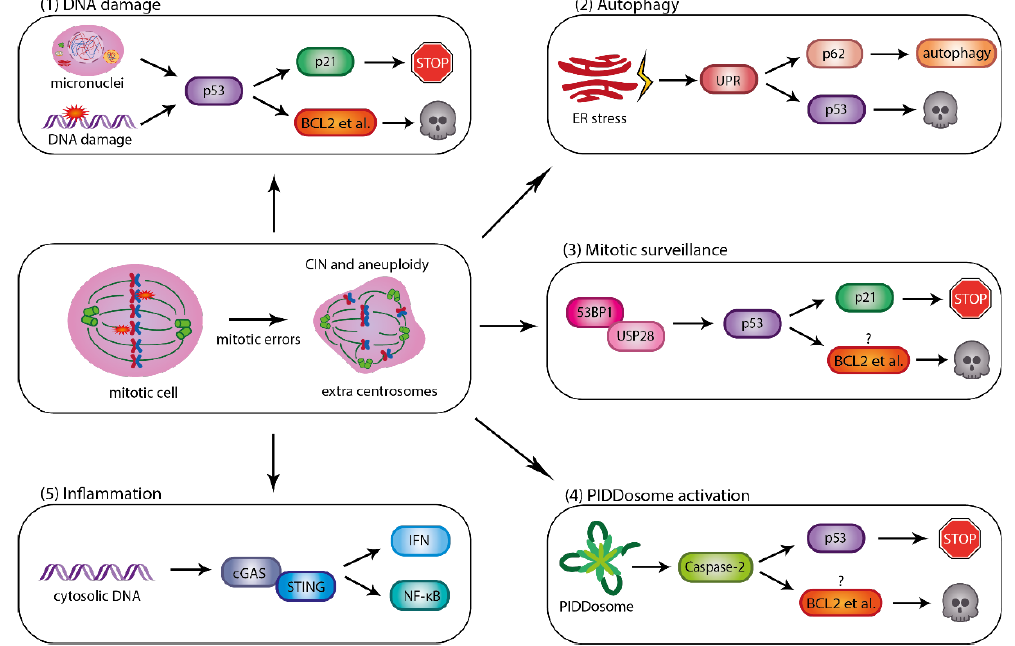
Figure 2. Consequences of chromosomal mis-segregation or mitotic slippage are diverse. ( 1 ) p53 activation due to DNA damage, e.g., emanating from fragile micronuclei can trigger p21 dependent cell cycle arrest or BCL2 protein family dependent apoptosis. ( 2 ) ER stress and subsequent unfolded protein response (UPR) as a result of aneuploidy-induced protein imbalances or aggregation can trigger autophagy, involving p62, and/or result in p53 activation leading to apoptotic cell death. ( 3 ) Delays in mitotic progression (> 90 min) can trigger a DNA damage-independent p53 response, involving p53 binding protein 1 (53BP1) and ubiquitin specific protease 28 (USP28), limiting MDM2- dependent p53 degradation. Cells may either arrest or die, potentially in a BCL2-regulated manner. ( 4 ) Similarly, independent of DNA damage, amplification of centrosomes triggers PIDDosome for- mation, MDM2 cleavage, p53 stabilization and p21 dependent cell cycle arrest. If and how extra centrosomes trigger apoptotic cell death remains uncertain, but it may involve again the BCL2 fam- ily. ( 5 ) Aggregation of cytosolic dsDNA, e.g., as a result of micronuclei formation, leads to cGAS- STING dependent sterile inflammation, resulting in interferon (IFN) production or induction NF- κB signalling , promoting cell recognition and clearance.